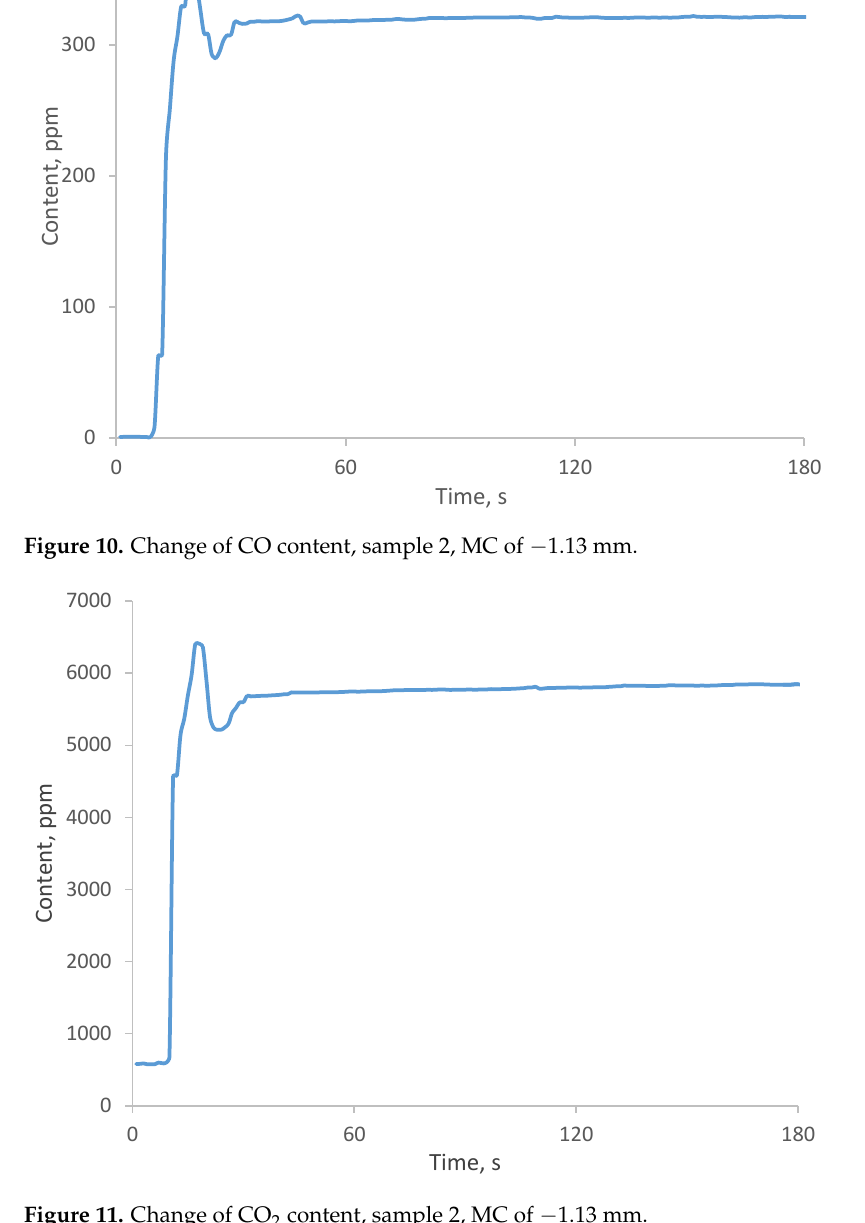
Figure 11. Change of CO 2 content, sample 2, MC of − 1.13 mm.